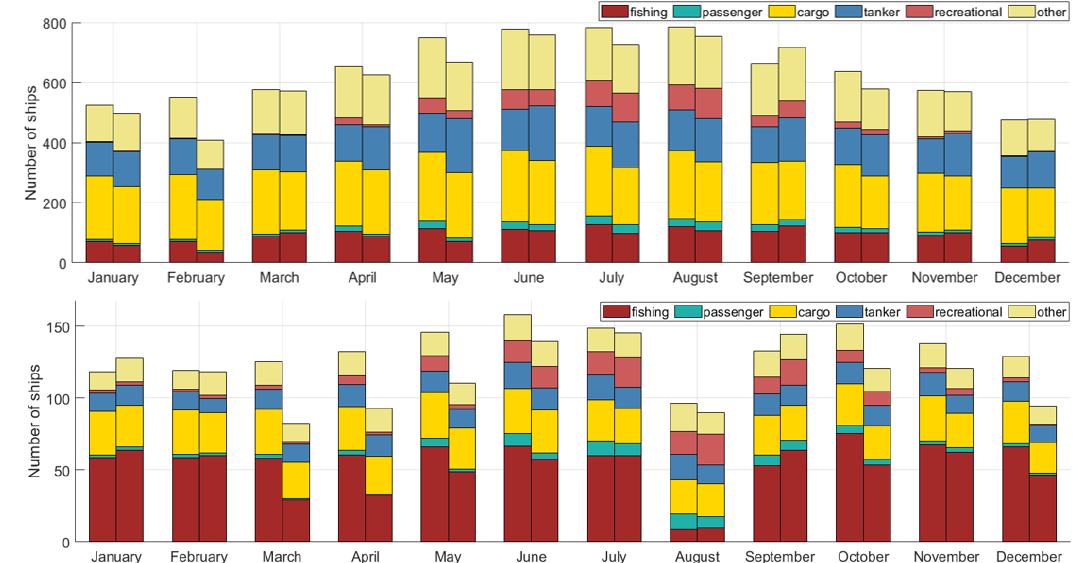
Figure 2. The total number of ships in test area 1 ( upper ) and test area 2 ( lower ). The left bar of each month is for the 3-year average (from 2017 to 2019). The right bar of each month is for 2020. The different colors in the bars correspond to different ship